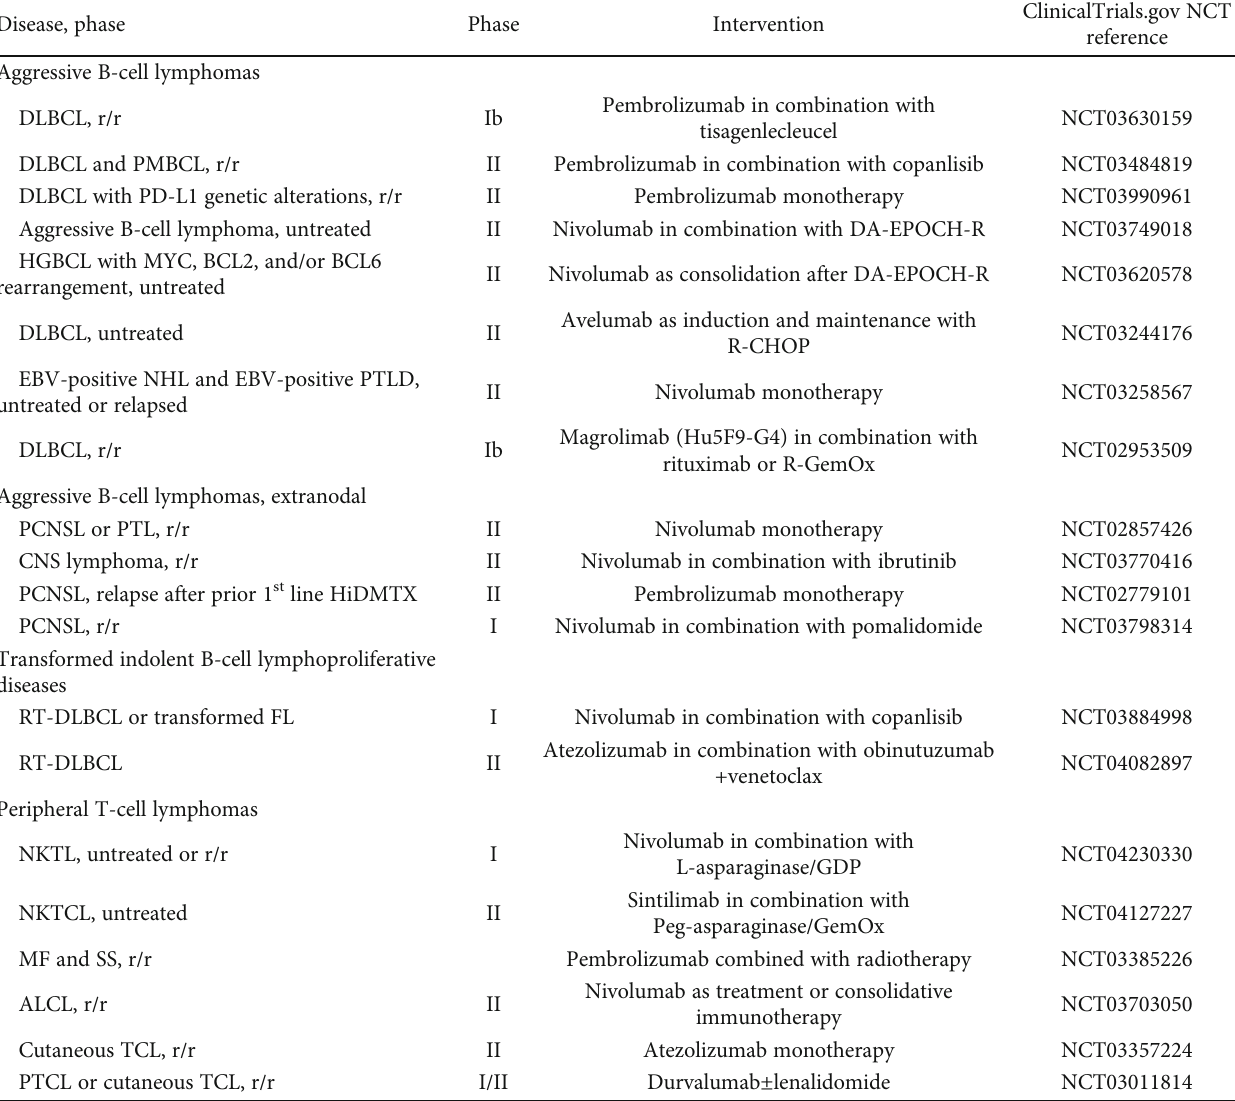
Table 3: Summary of selected ongoing clinical trials of PD-1/PD-L1 ICIs in NHL. Disease,